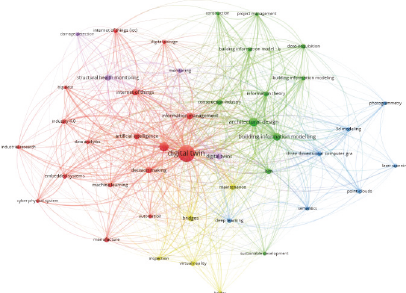
Figure 4: Network of co-occurring